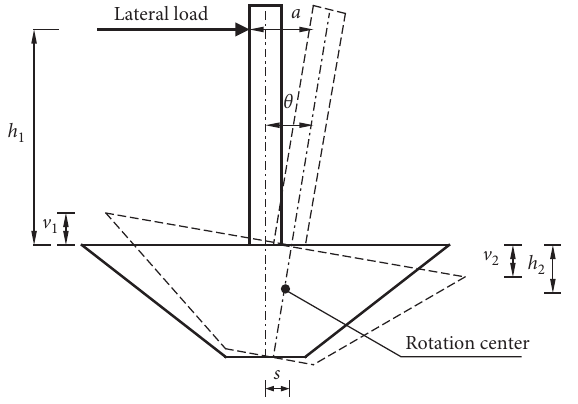
Figure 9: Sketch of rotation center